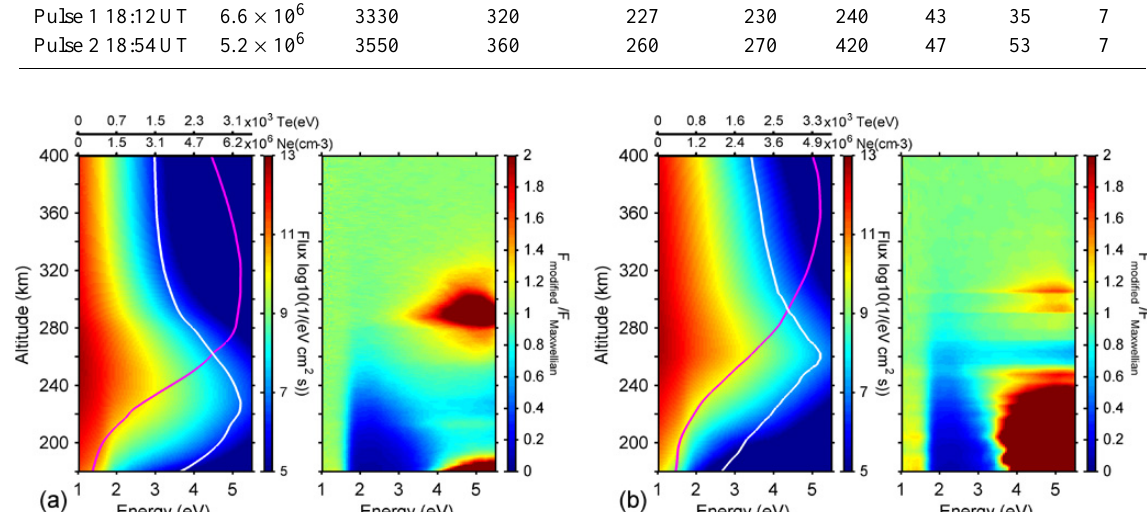
Fig. 2. (a) Left: Altitude profile of the differential flux of the high energy tail of the ionospheric thermal electrons for ionospheric conditions corresponding to the heating pulse at 18:12UT on 10 March 2002. The colour lines, white and magenta, present the altitude profiles of the ionospheric electron temperature and density, respectively. Right: Altitude energy variation of the ratio of the modelled differential electron flux to the Maxwellian flux; (b) same as panel (a) for the heating pulse at 18:54UT.